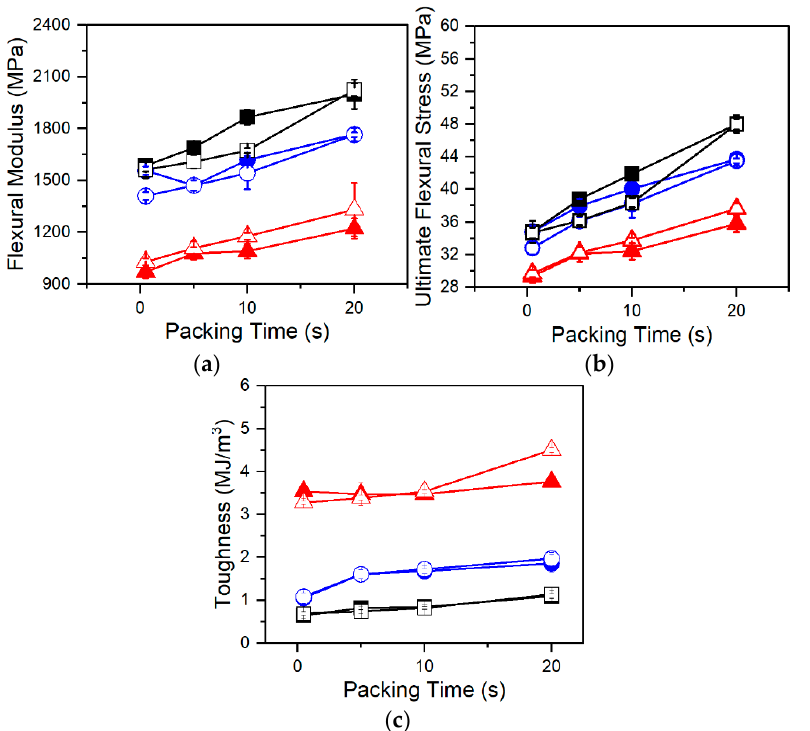
Figure 8. ( a ) Flexural modulus, ( b ) ultimate flexural strength, and ( c ) toughness of Resin A (red triangles), Resin B (blue circles), and Resin C (black squares) foamed at various packing times using AV CBA. Closed and open symbols indicate 1 wt% and 2 wt% CBA respectively.